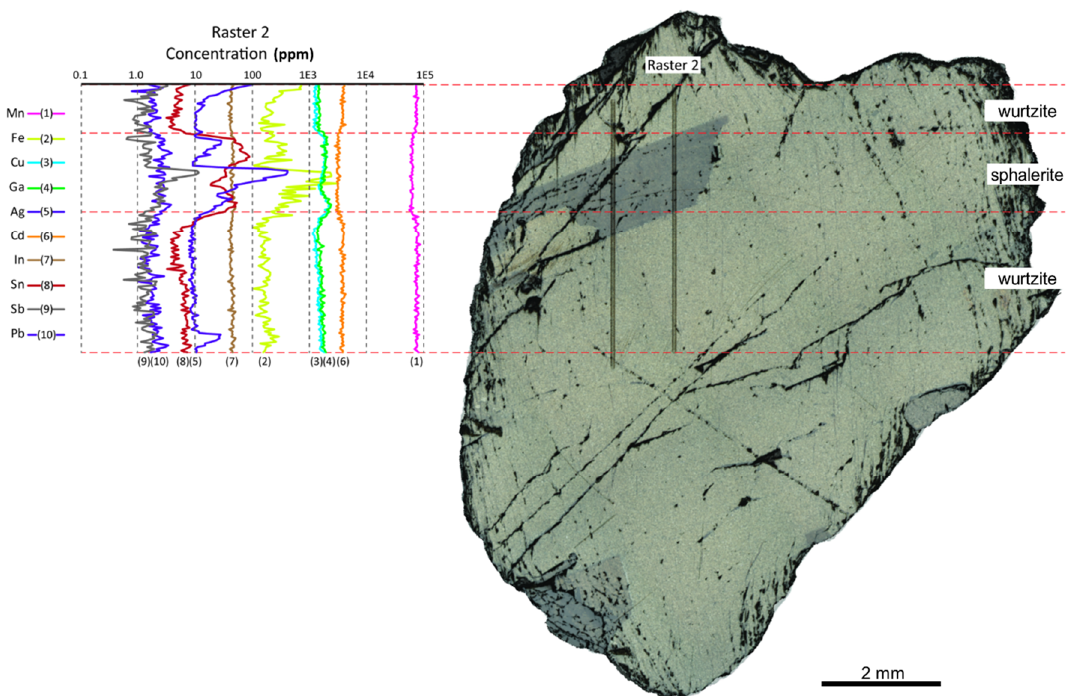
Figure 2. Photomicrograph of sample from Merelani Hills, Tanzania (G34171), taken in transmitted light under crossed nicols. The wurtzite-4H regions, that make up most of the sample are pale dark green, while the epitaxially intergrown sphalerite is dark grey. The position of the two LA-ICP MS line scans are indicated. A log plot showing the variations in concentrations of minor and trace elements along Line scan 1 is superimposed.